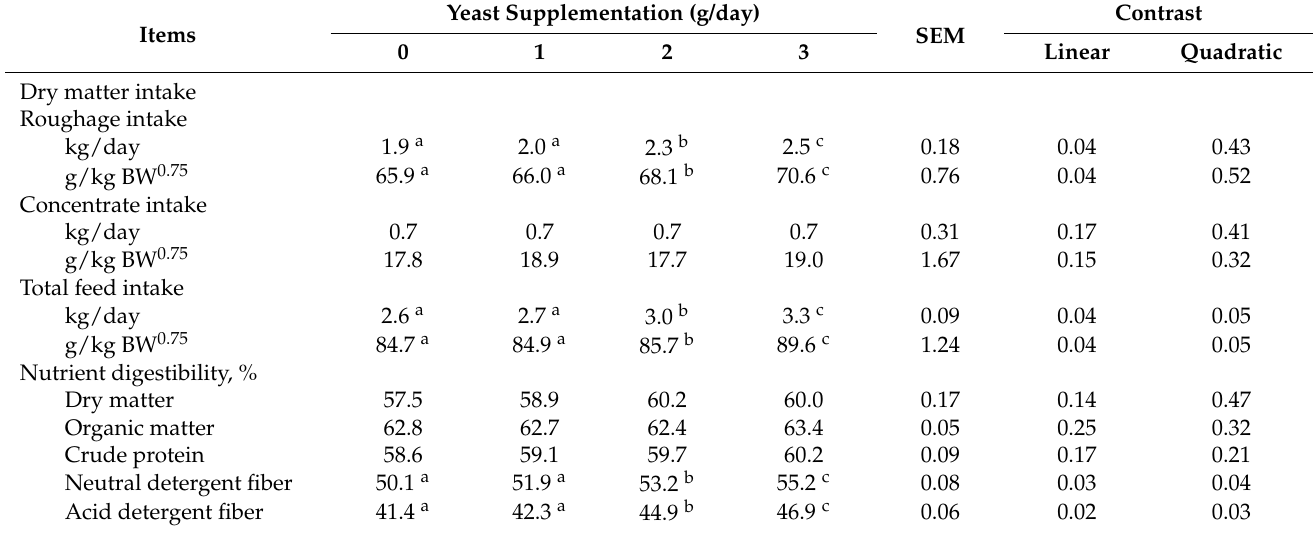
Table 2. Effect of yeast supplementation on voluntary feed intake and nutrient digestibility in Thai native beef cattle.